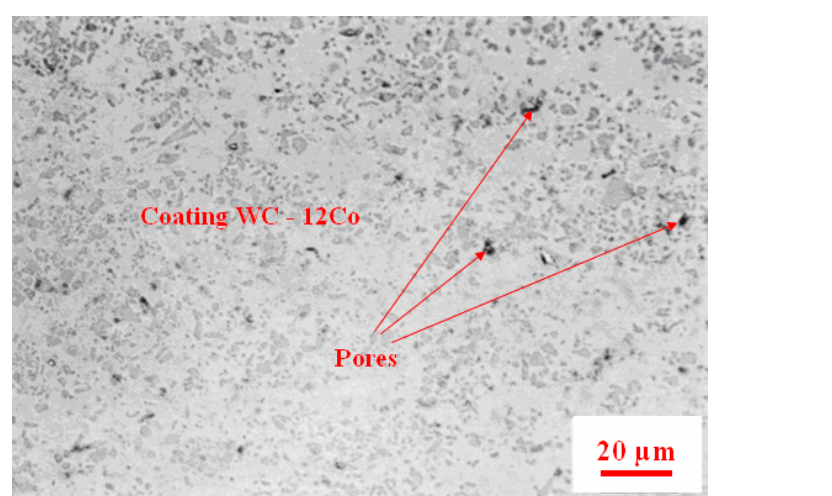
Figure 8 – Microstructure of the WC – 12wt.%Co coating deposited with a helium feed rateof 32 l/min